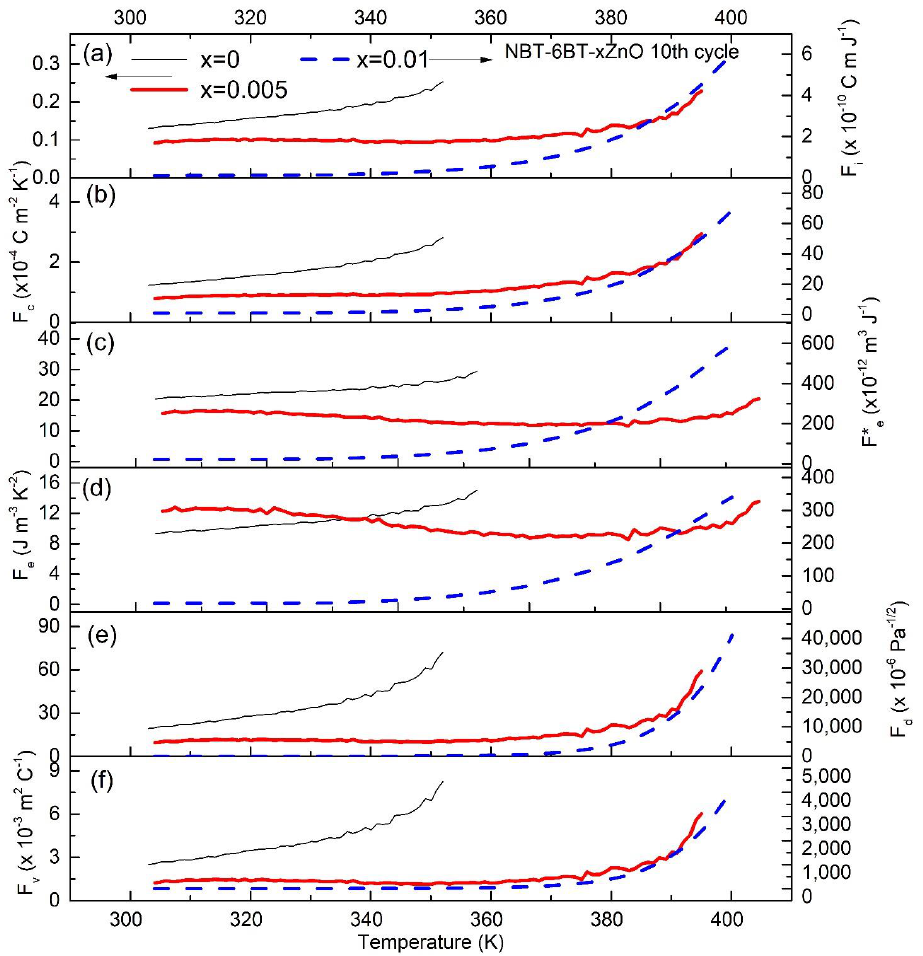
Figure A1. Pyroelectric figures of merit versus temperature plots after tenth heating cycle for NBT- 6BT-xZn (x = 0.5 and 1%): ( a ) current responsivity ( 𝐹 𝑖 ), ( b ) the pyroelectric figure of merit ( 𝐹 𝑐 ), energy harvesting ( c ) 𝐹 𝑒∗ , and ( d ) 𝐹 𝑒 . ( e ) Detectivity ( 𝐹 𝑑 ) and ( f ) the voltage responsivity ( 𝐹 𝑣 ).